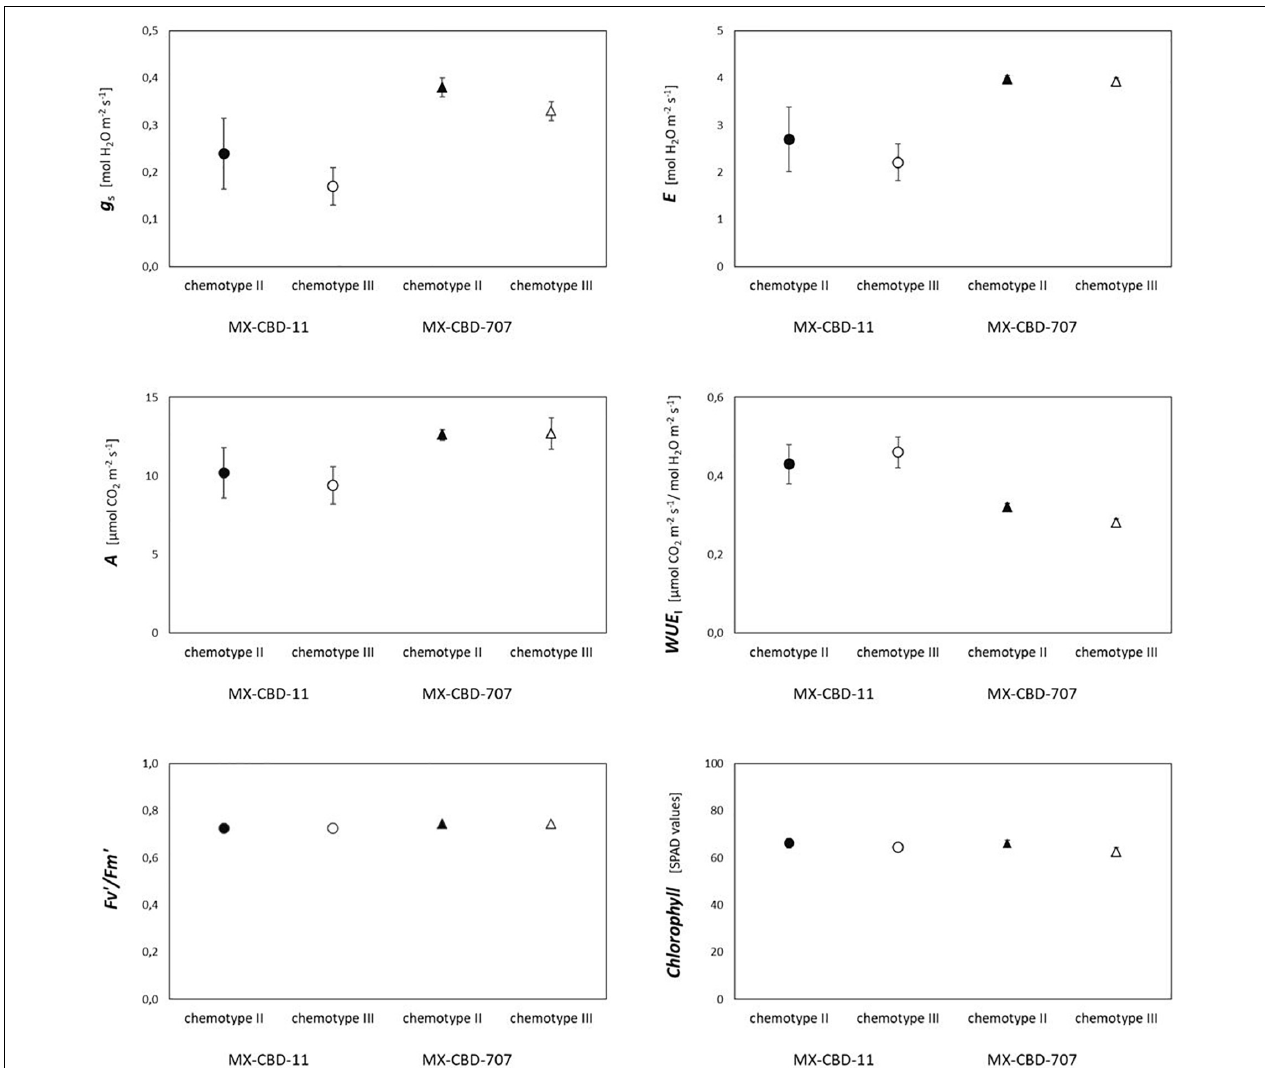
FIGURE 4 | Photosynthetic traits of two breeding populations of medical cannabis MX-CBD-11 and MX-CBD-707. The data are presented as the mean ± standard error ( N = 5).